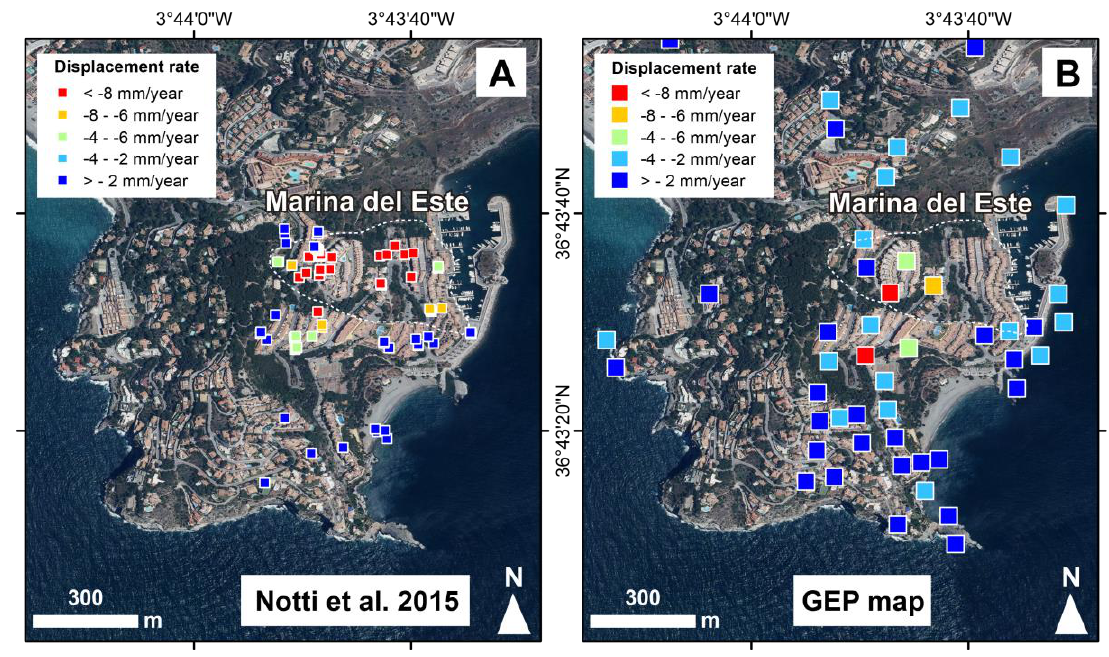
Figure 6. Comparison between the displacement rates measured by Notti et al. [18] ( A ) and the GEP map ( B ) in the Marina del Este resort. The boundary of the active landslide is indicated by white dotted lines.